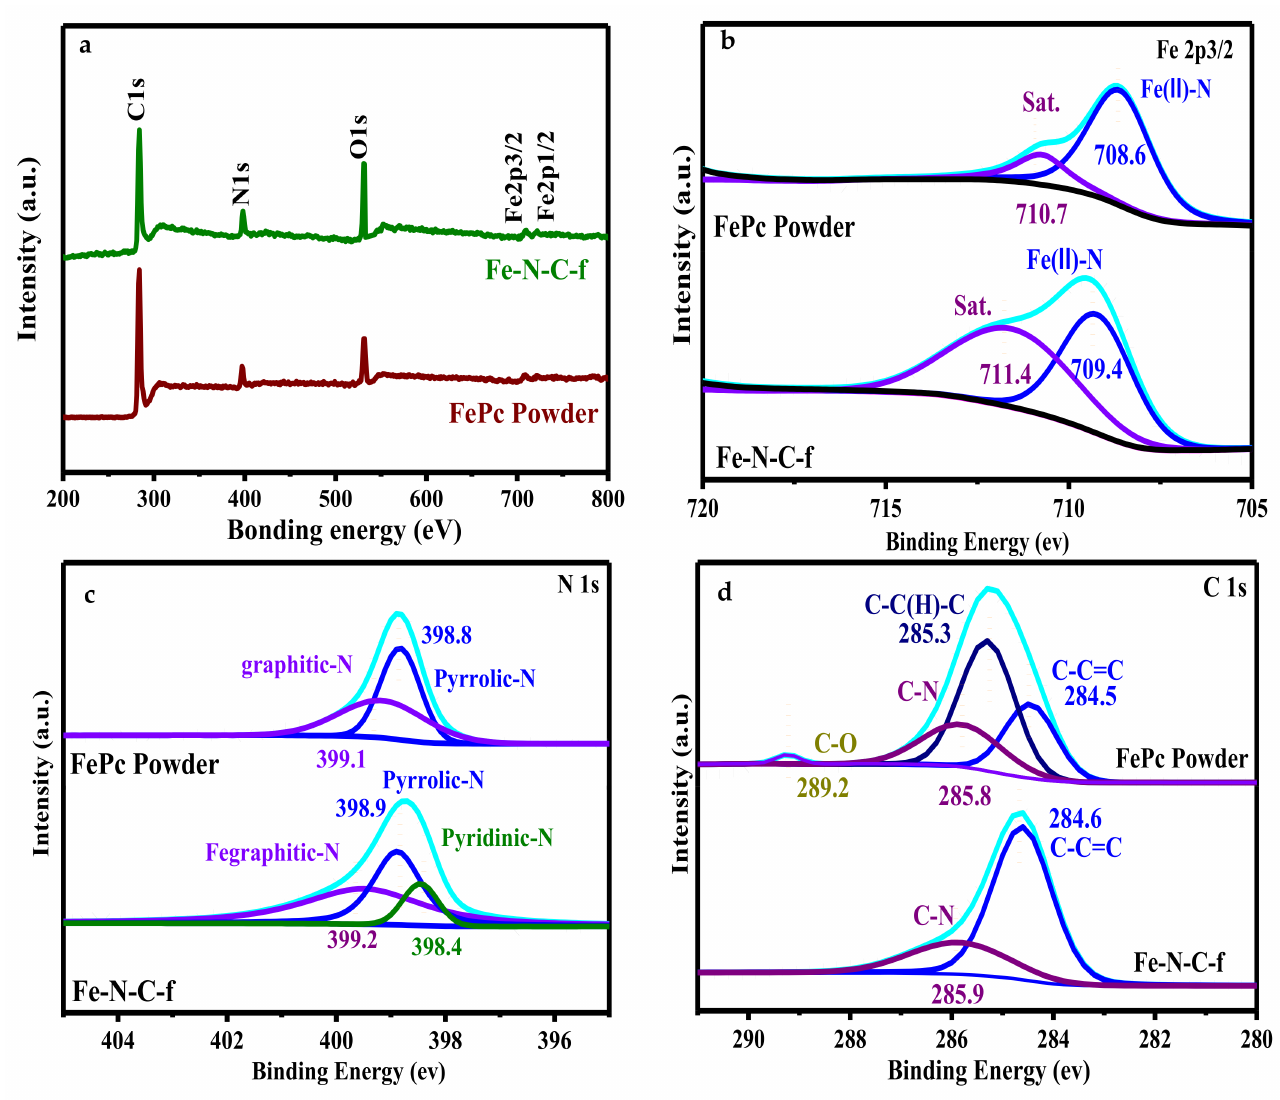
Figure 6. XPS spectra of FePc powder and Fe–N–C-f catalyst: ( a ) survey spectrum; ( b ) Fe 2p 3/2 ; ( c ) N 1s; ( d ) C